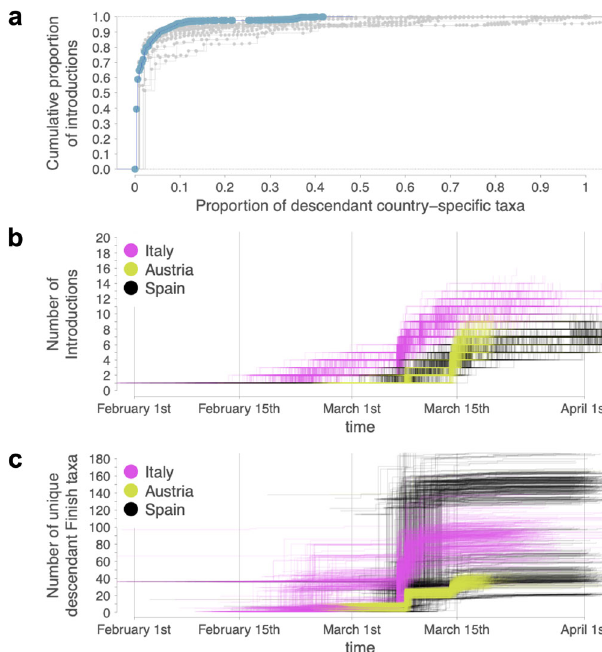
Fig. 4 Empirical cumulative distribution function plot and temporal cumulative number of introductions. a The proportion of descendant country-speci fi c taxa (blue for Finland and gray for each of the 16 selected European countries excluding Latvia and Estonia for which few genomes were available) re fl ects the proportion of taxa from a given country that are descendants from a given introduction. The fi gure shows that the majority of introductions are responsible for a relatively small fraction of the taxa sampled in a given country, while a few introductions are responsible for a large proportion of the taxa sampled in a given country. Cumulative number of phylogeographic transitions ( b ) and cumulative number of unique Finnish descendant state taxa ( c ) over time from Italy, Austria and Spain to